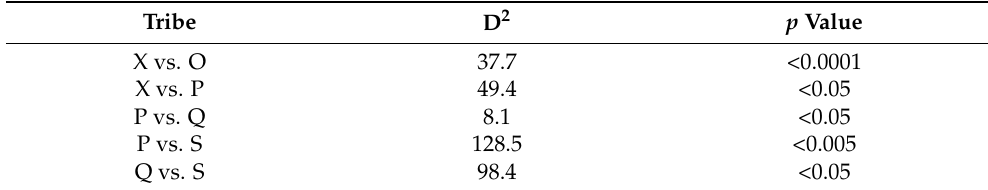
Table 2. Squared Mahalanobis distances between tribes with p values of the canonical variate analysis to quantify differences between shapes. Only significant distances are shown. Abbreviations: O: